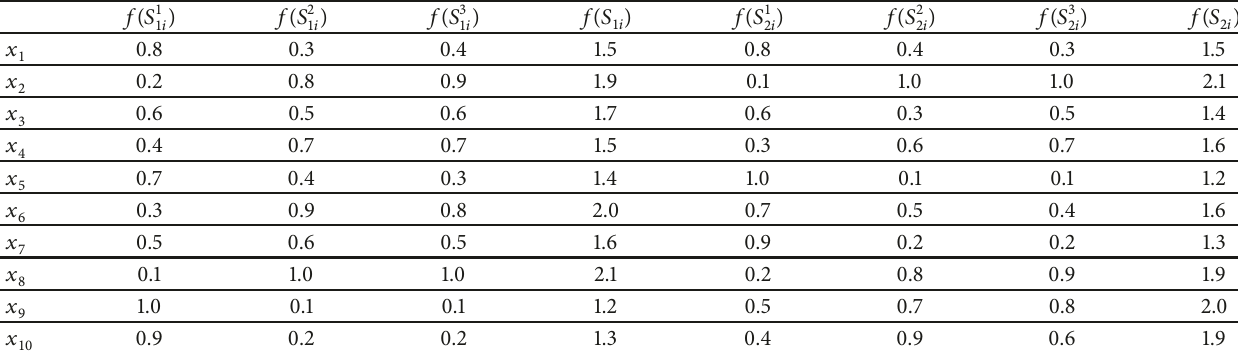
Table 10: The Borda score of the ranking of the dimensions of ability and reputation and the total